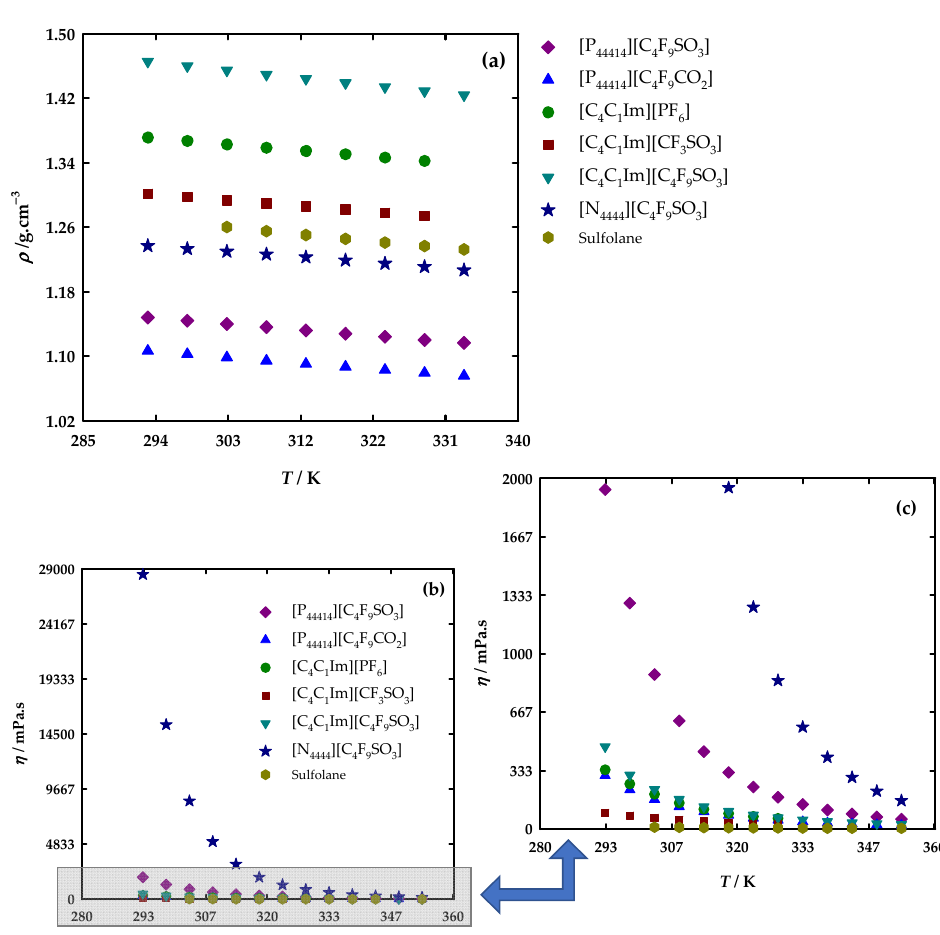
Figure 4. Comparison of: ( a ) density values; ( b ) dynamic viscosity; and with ( c ) an extension of dynamic viscosity for low values of the novel synthesized FILs based on [P 44414 ] + cation with traditional ILs [18,41,42] and a common organic solvent (sulfolane) [43].